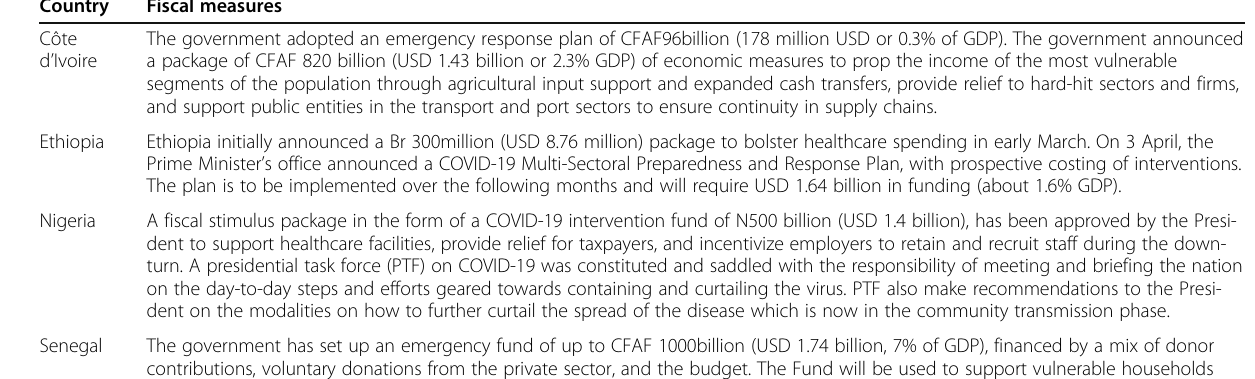
Table 4 Fiscal measures implemented by selected African countries [39]